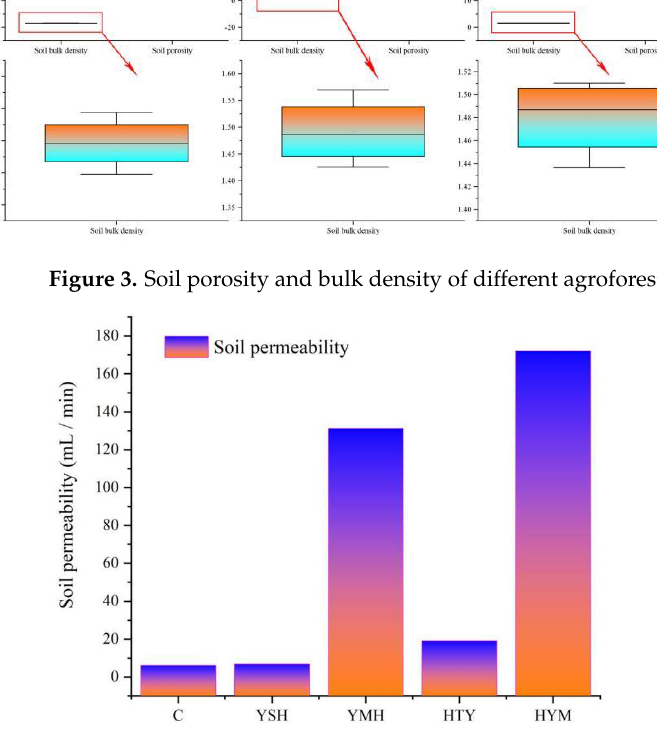
Figure 4. Soil permeability of different agroforestry.